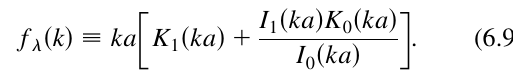
(cid:3) 0 : 98 v . The voltage is b c 4 CV (cid:4) z; t (cid:6) =(cid:5) , and the normalized distance n (cid:3) b 0 4 2 z=l 4 2 v t=l and t , respectively. The ion n (cid:3) b n (cid:3) b b (cid:3) (cid:5) (cid:5) t (cid:6) 2 exp (cid:5) (cid:4) z b b 0 n n